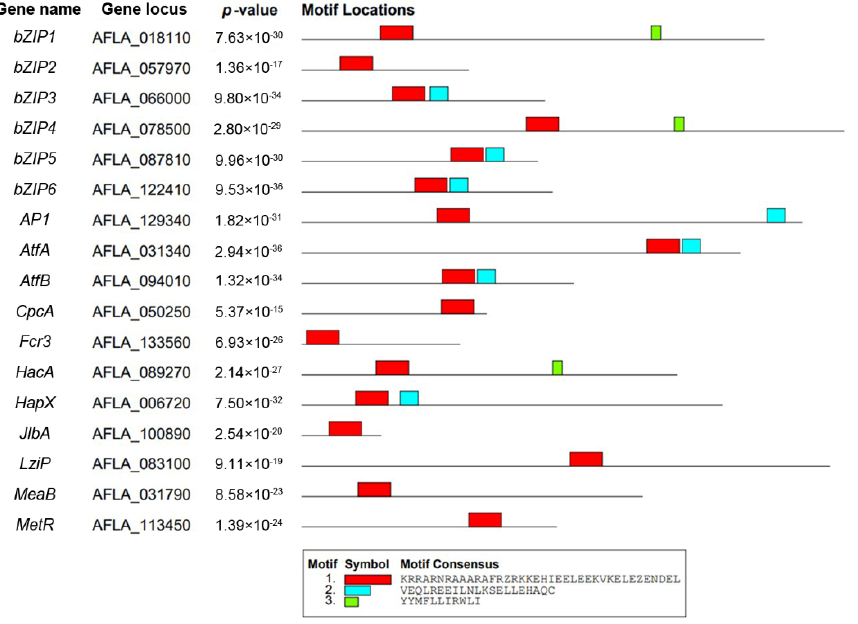
Figure 1. Analysis of the conserved motifs of bZIP family transcription factors in Aspergillus flavus